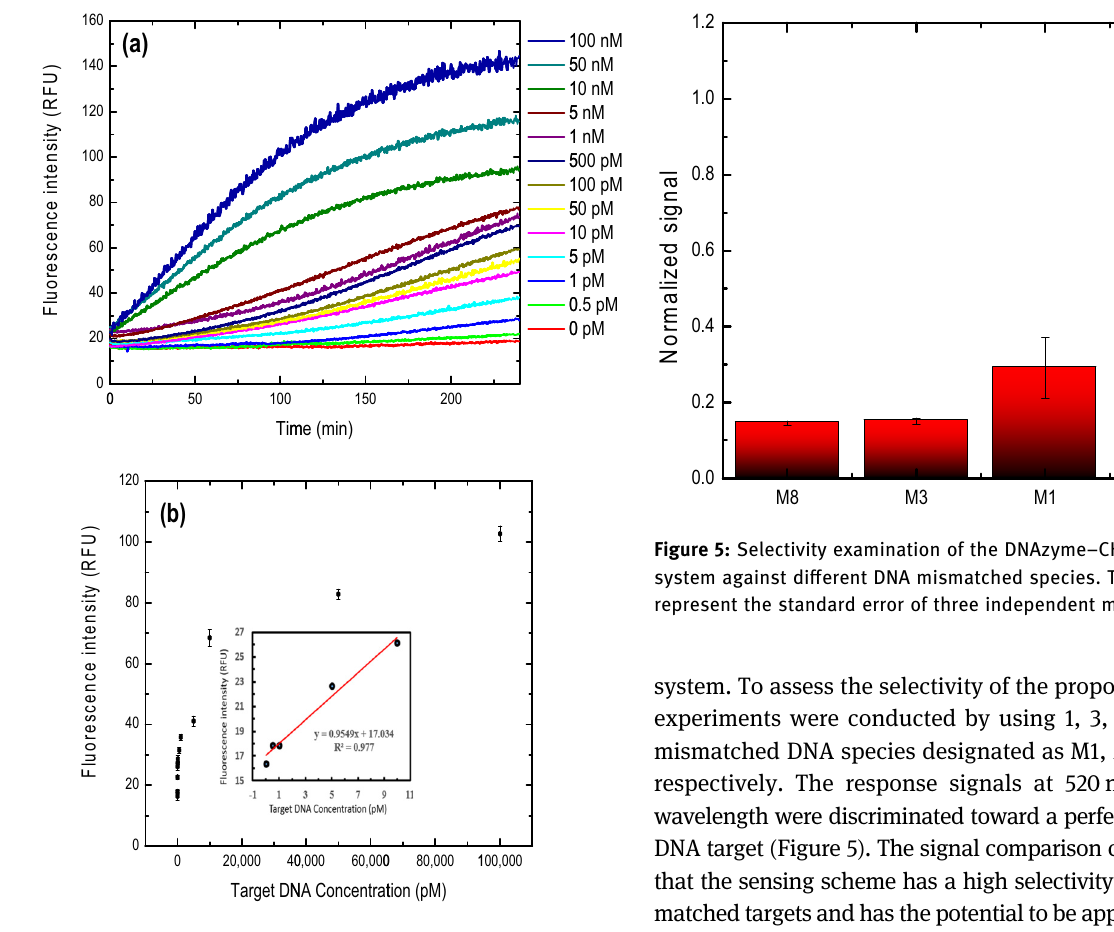
Figure 4: Sensitivity analysis. ( a ) Fluorescence intensity under various target concentrations. ( b ) Fluorescence responses after 100 min for di ff erent target DNA concentrations. The inset shows a linear relationship at a low concentration regime from 0 to 10 pM. The error bars represent the standard error of three independent measurements.